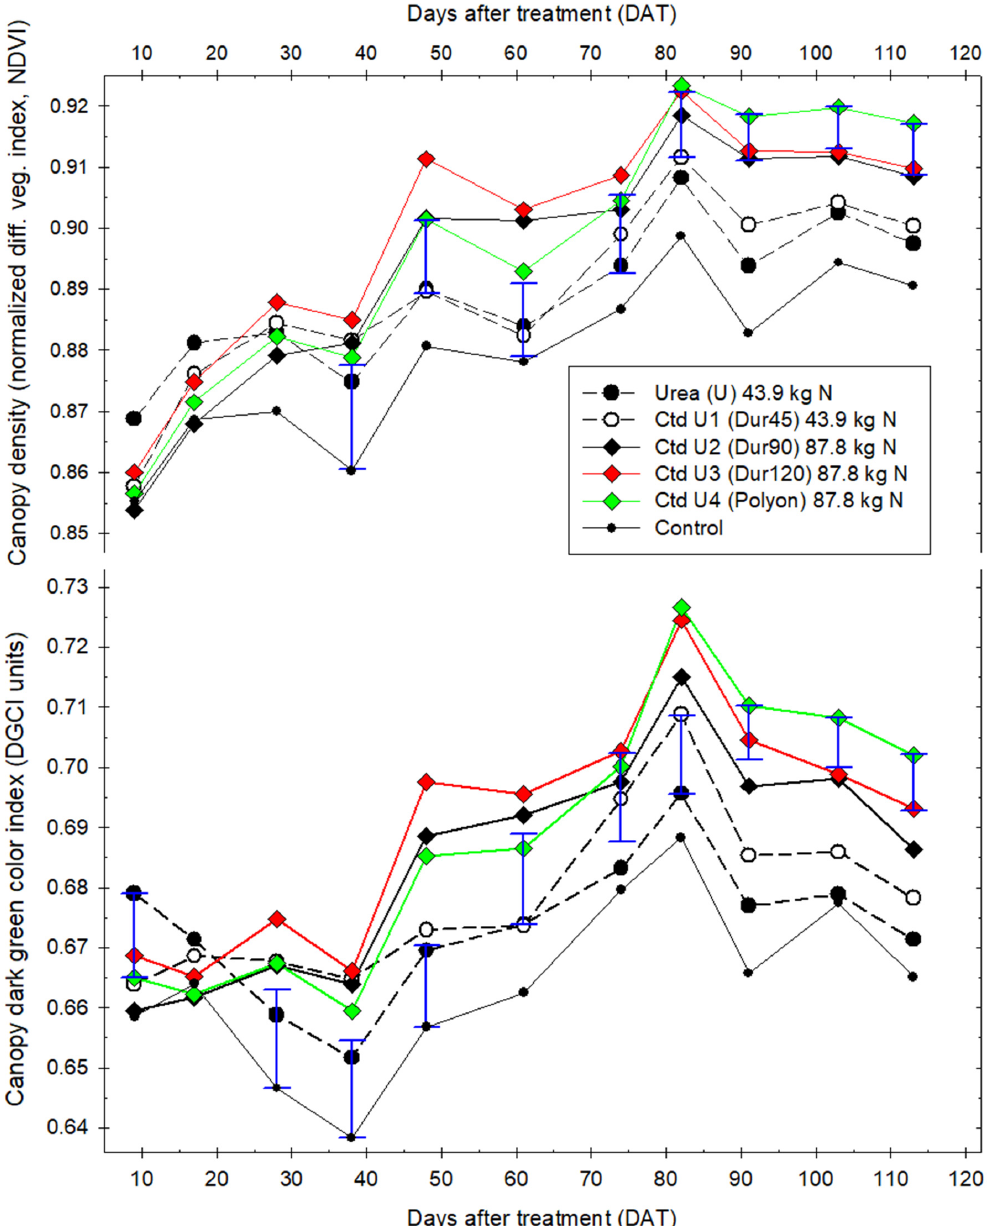
Figure 2. Kentucky bluegrass canopy dark green color index (DGCI) and density (normalized diff. veg. index, NDVI) by fertilizer treatment (ha − 1 ) and days after treatment (DAT). Blue error bar lengths denote Fisher’s Protected Least Significant Difference (LSD) at a 0.05 alpha level.